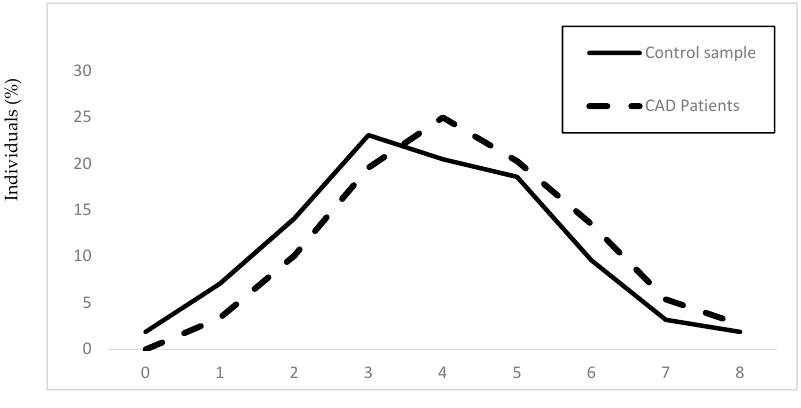
Figure 1. Frequencies of homozygous recessive characteristics in the group of patients with CAD and the control sample. Control sample: N = 156, x hrc/17 = 3.75 ± 1.69; CAD patients: N = 148, x hrc/17 = 4.24 ± 1.59 ( z = − 2.498, p < 0.012); V Control sample = 45.07%, V CAD patients = 37.50%.